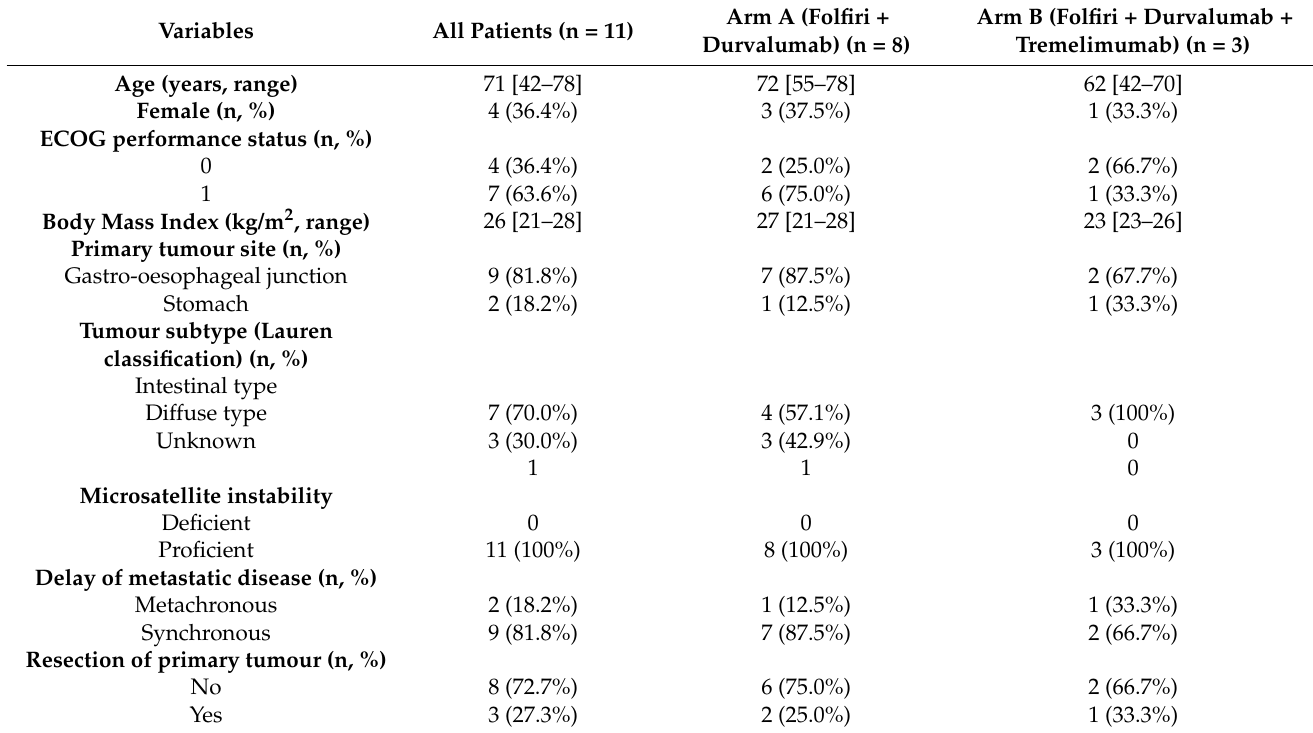
Table 1. Patient and tumour